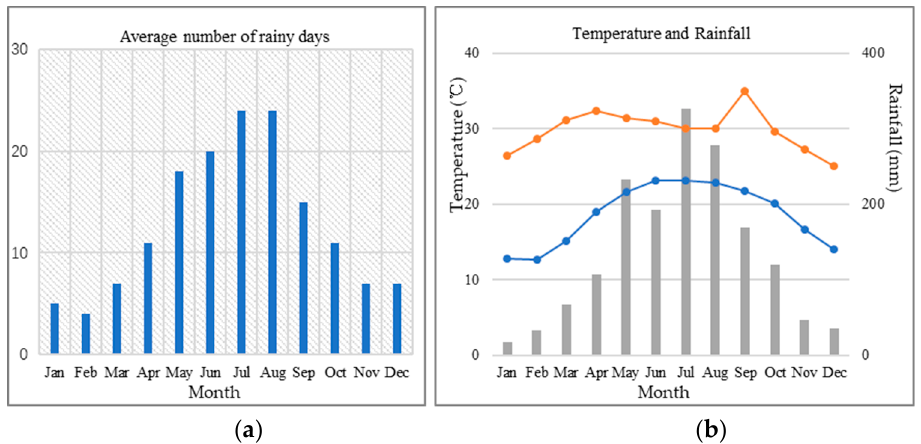
Figure 4. Meteorological data for north Laos: ( a ) number of rainy days per month, ( b ) temperature and precipitation per month; lines represent temperature, and histogram represents rainfall. Data source: World Meteorological Organization statistics for approximately 30 years. (http://worldweather.wmo.